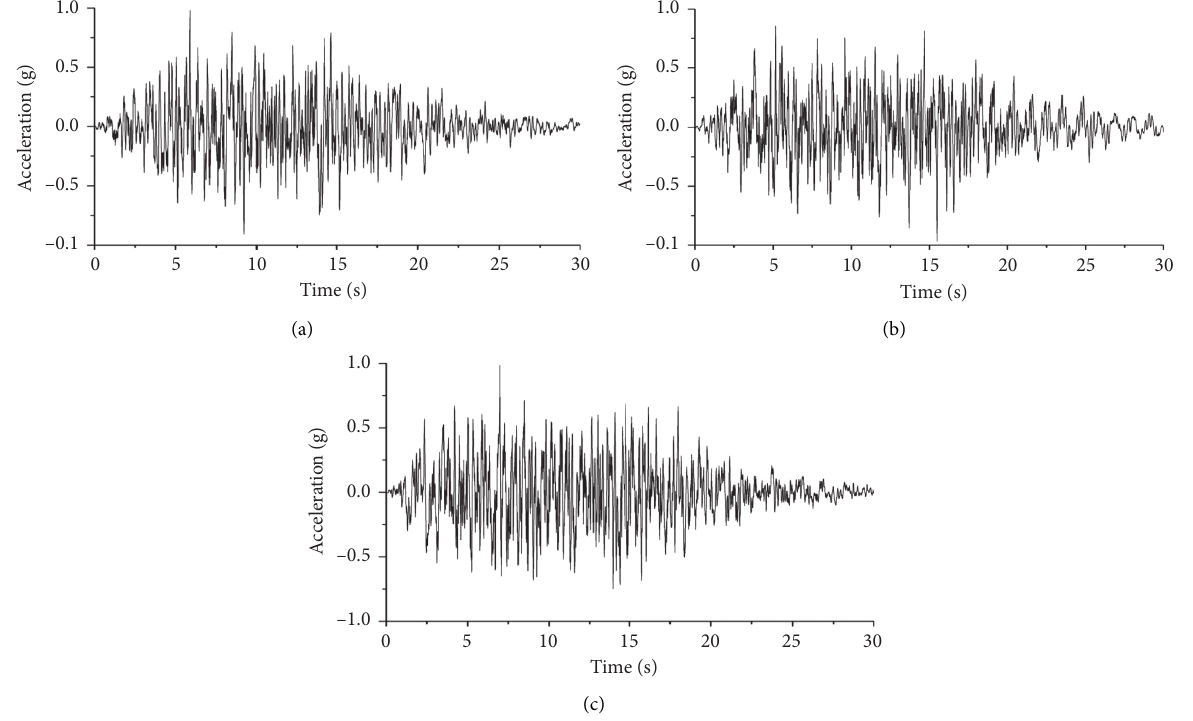
Figure 13: The seismic wave time histories in three directions. (a) Cross-section direction. (b) Stream direction. (c) Vertical direction.